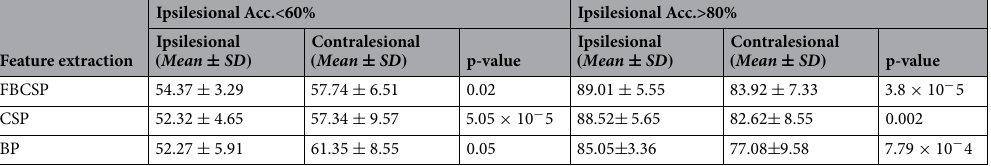
Table 3. Comparison of the average 10 × 10 fold cross-validation accuracy of the ipsilesional and contralesional BCI for those with ipsilesional BCI accuracy below 60% and those with the ipsilesional BCI accuracy above 80%, obtained using three different BCI feature extraction methods. Acc. accuracy, SD standard deviation.